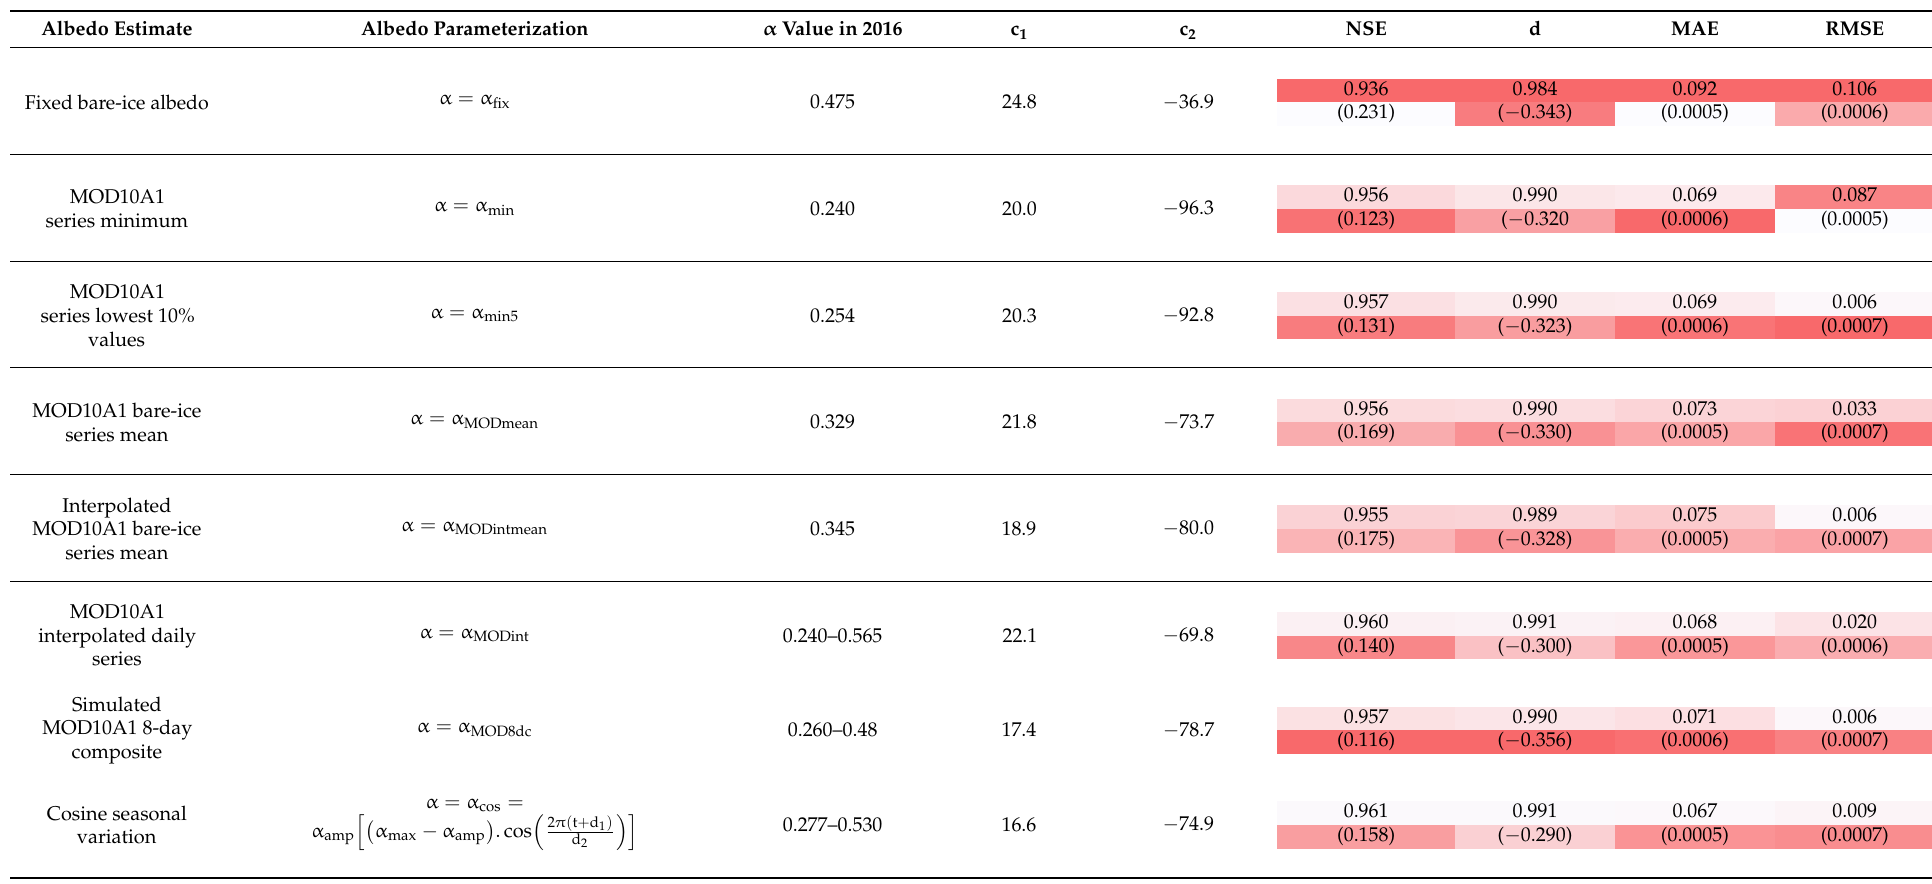
Table 1. Description of constant and time-variant albedo parameterizations explored for prediction of cumulative melt over the ROI, including the parameter values and Nash-Sutcliffe, Willmott, mean absolute and root mean square error goodness-of-fit metrics (respectively, NSE, d, MAE and RMSE) to observed ablation over the JJA season. The associated goodness-of-fit metrics for the average hourly melt rate between on-site ablation observations are shown in parentheses. NSE and d are dimensionless, MAE and RMSE are in m w.e. Goodness-of-fit metrics are displayed with a red relative heatmap shading, ranging from red for weaker to white for stronger model